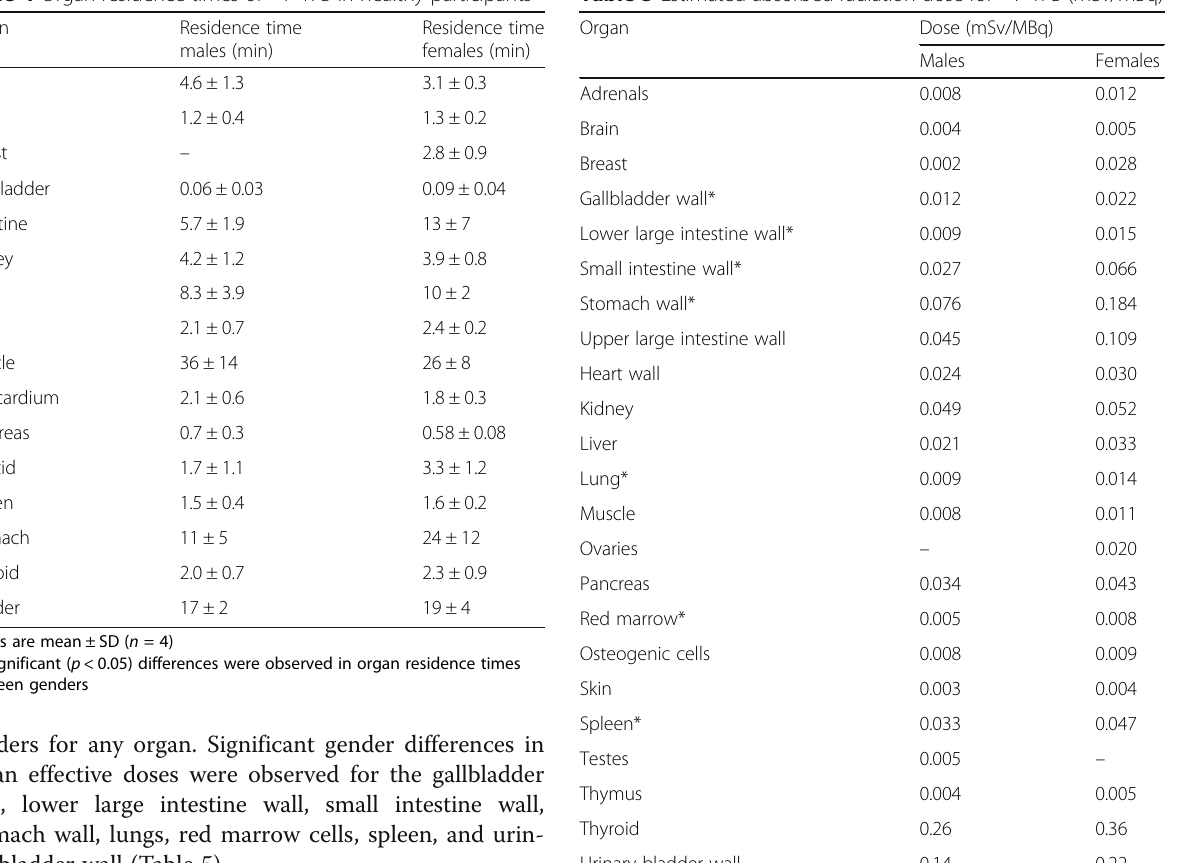
Table 5 Estimated absorbed radiation dose for 18 F-TFB (mSv/MBq)